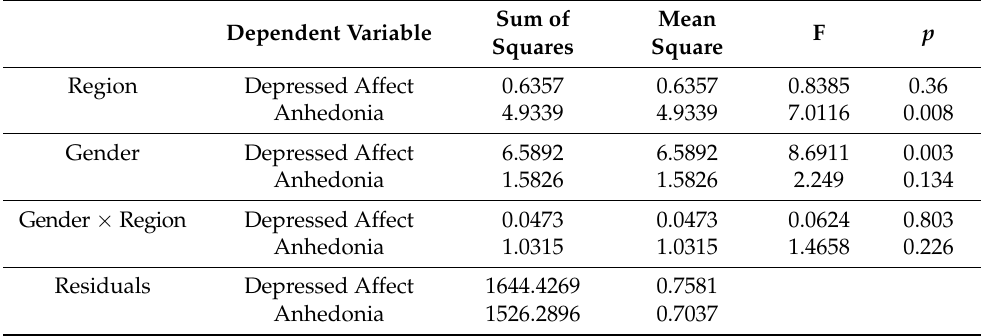
Table 5. Univariate Tests to Probe the Effects of Gender and Region on the CFPS-2018 Participants’ Depressed Affect and Anhedonia ( n =